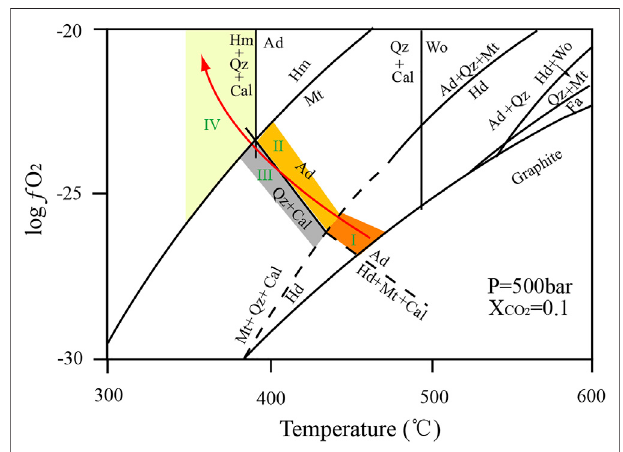
FIGURE10| Temperature – log f O2 diagramat500 barandX CO2 =0.1for the system Ca – Fe – Si – C – O – H (modi fi ed after Einaudi, 1981). The arrow shows the T-log f O2 path of magnetite mineralization in the Qia ’ erdunbasixi deposit (modi fi ed from Wang and Zhu, 2010). Ab — Albite; Ad — Andradite; Cal — Calcite; Di — Diopside; Fa — Fayalite; Hm — Hematite; Hd — Hedenbergit; Mt — Magnetite; Qtz — Quartz; Wo — Wollastonite.